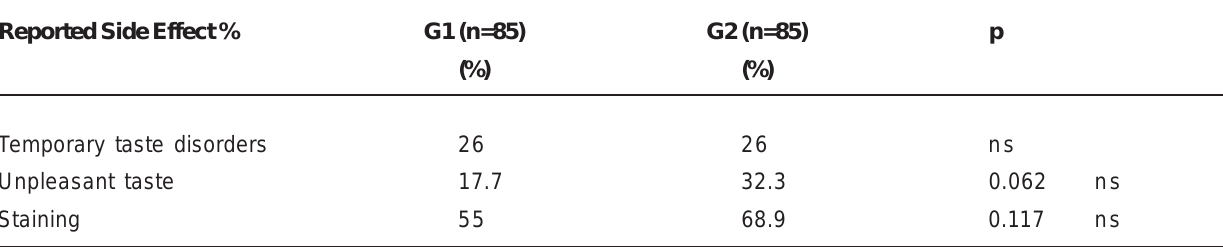
TABLE 2- Chi-square test for the perception of the side effects on both groups